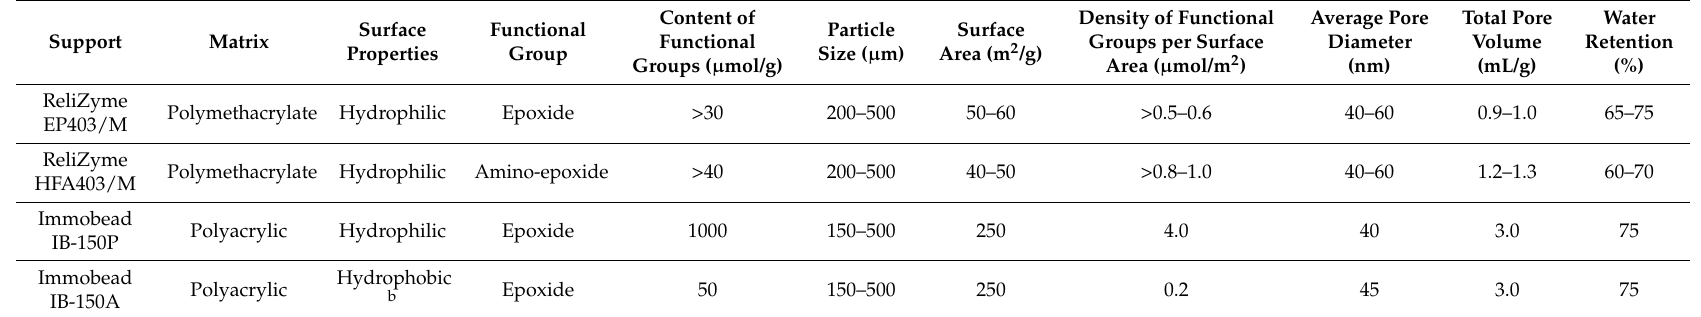
Table 1. Main properties of the different supports used in this study a .